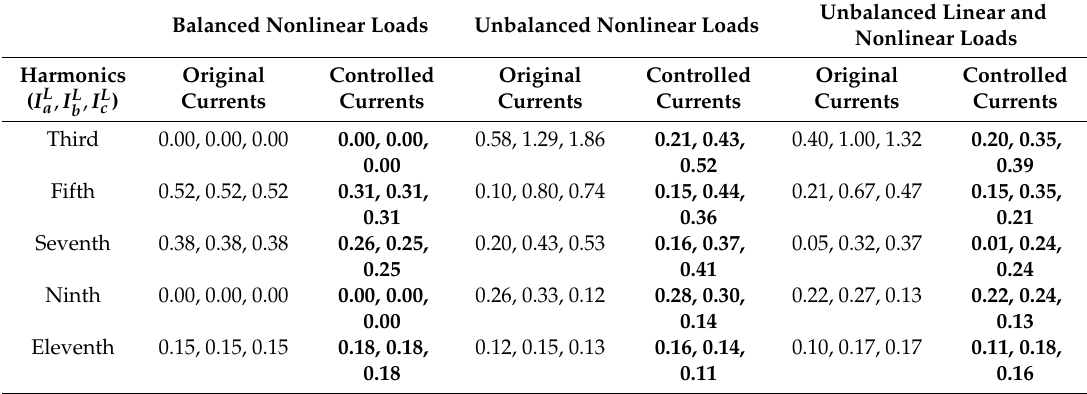
Table 3. Harmonics content attenuated by hybrid PI-LQR